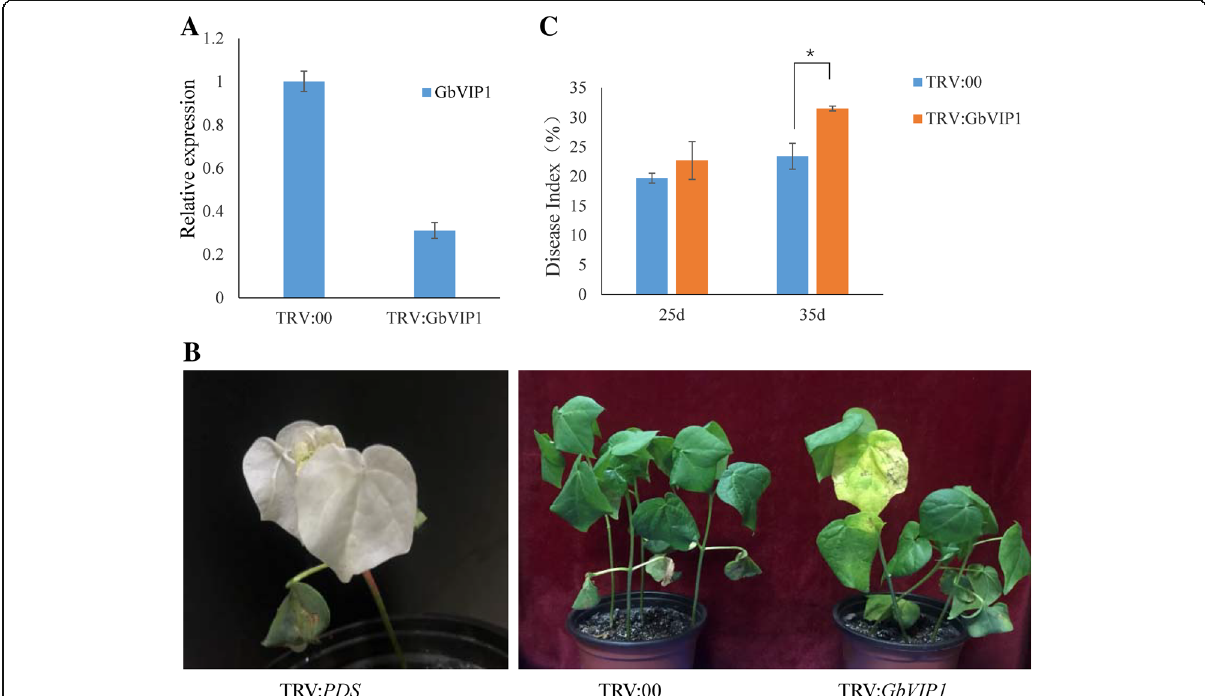
Fig. 3 Silencing GbVIP1 gene resulted in decreased Verticillium wilt resistance in cotton. a Expression levels of GbVIP1 in silenced and wild type cotton seedlings. b Phenotypes of cotton seedlings after V. dahliae inoculation. TRV:00 represents empty vector, TRV:GbVIP1 represents GbVIP1 silenced and TRV:PDS represents PDS silenced. c Disease index of silenced and wild type cotton seedlings measured at 25 and 35days after